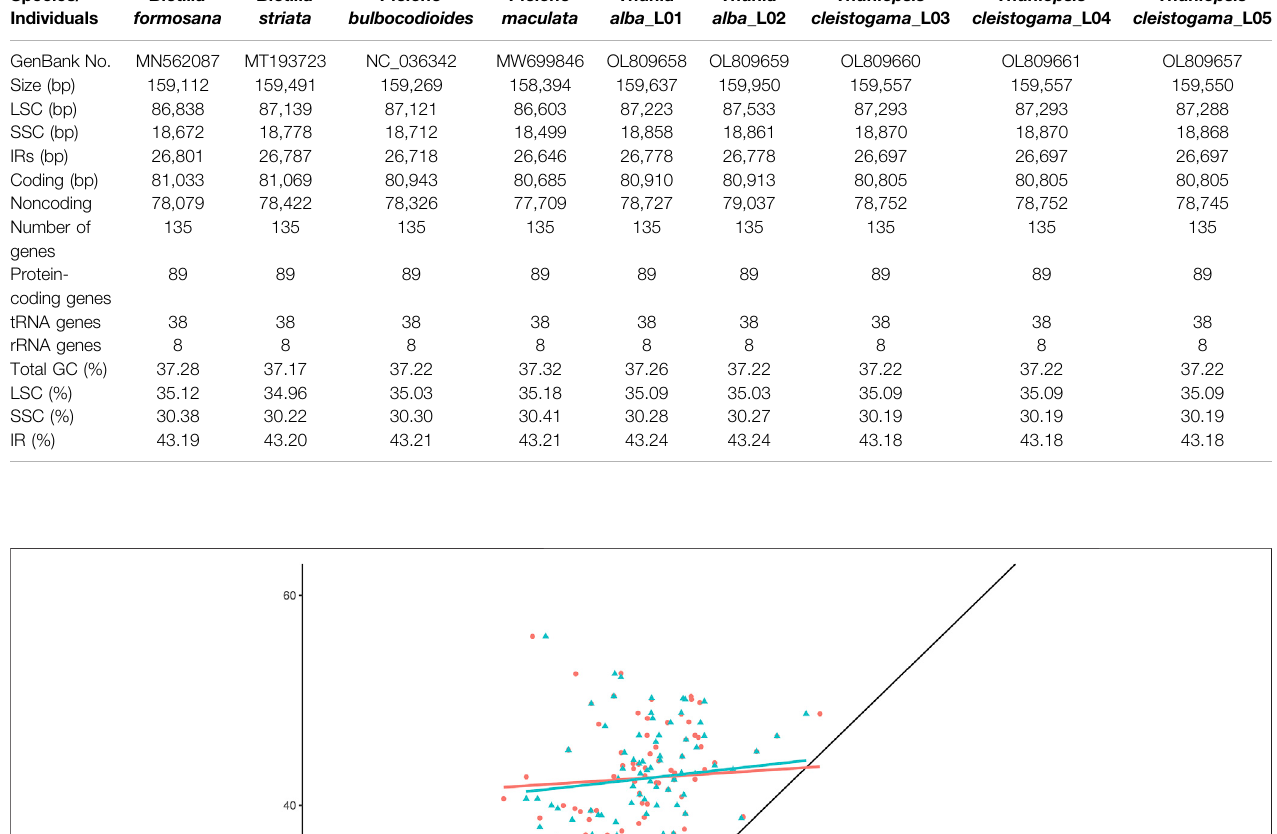
in GC3 ( Supplementary Table S3 ), which was widely used to better elucidate the codon usage variation. The neutrality plot revealed a weak correlation between GC3 and GC12. As shown in Figure 2 , the correlation coef fi cient was very low, indicating that the GC composition for the three positions of the codon differed.